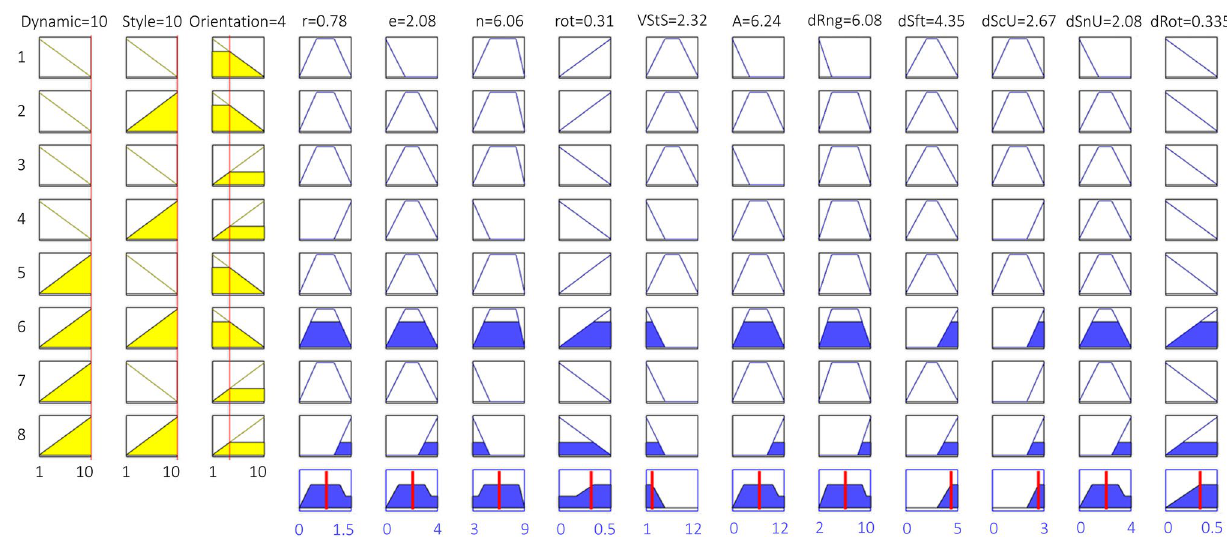
Fig. 10 Fuzzy rule set and defuzzification 2